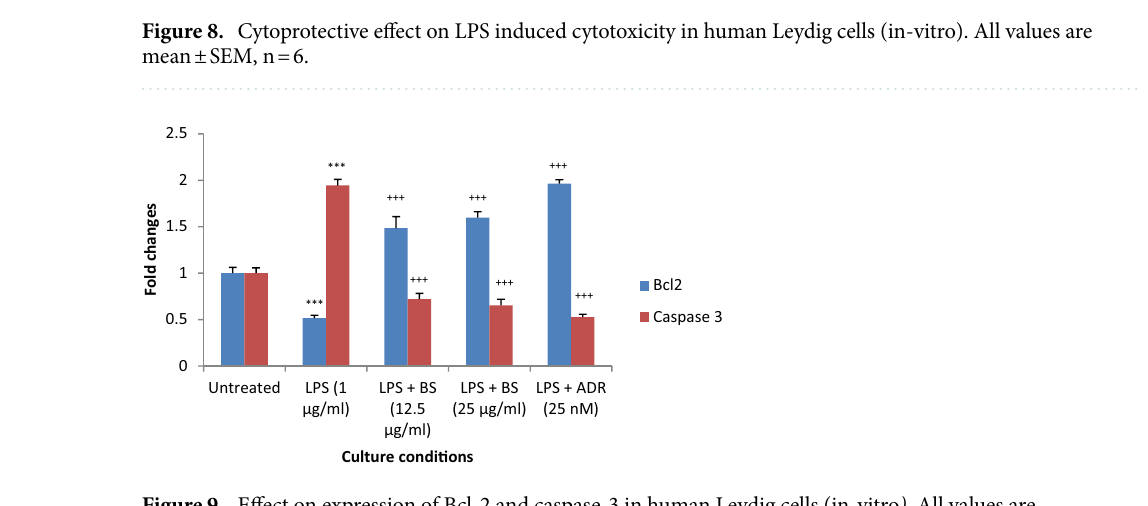
Figure 9. Effect on expression of Bcl-2 and caspase-3 in human Leydig cells (in-vitro ) . All values are mean ± SEM, n = 6. *** P < 0.001 compared to control, +++ P < 0.001 compared to LPS treated cells. B S Boswellia sacra extract, ADR